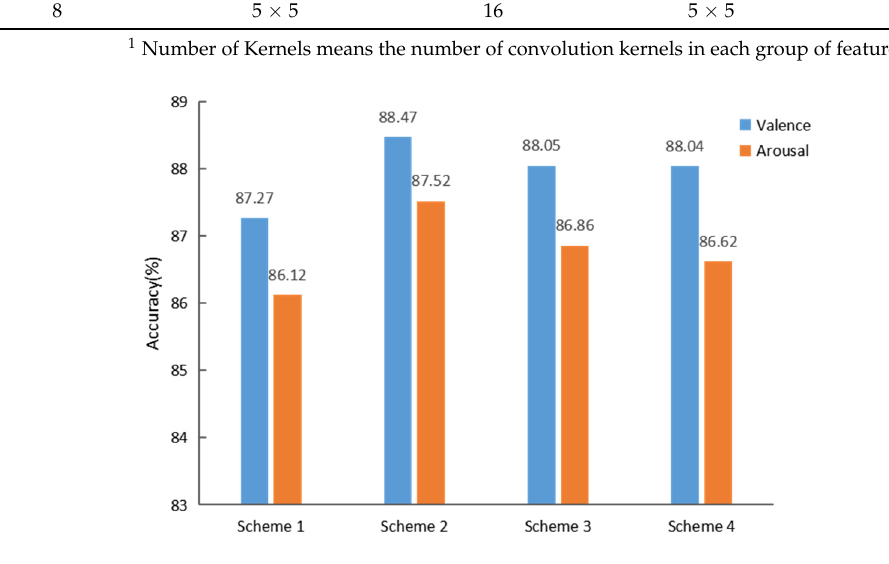
Figure 9. Performance comparison of models with different numbers of neurons in the fully con- nected layer.